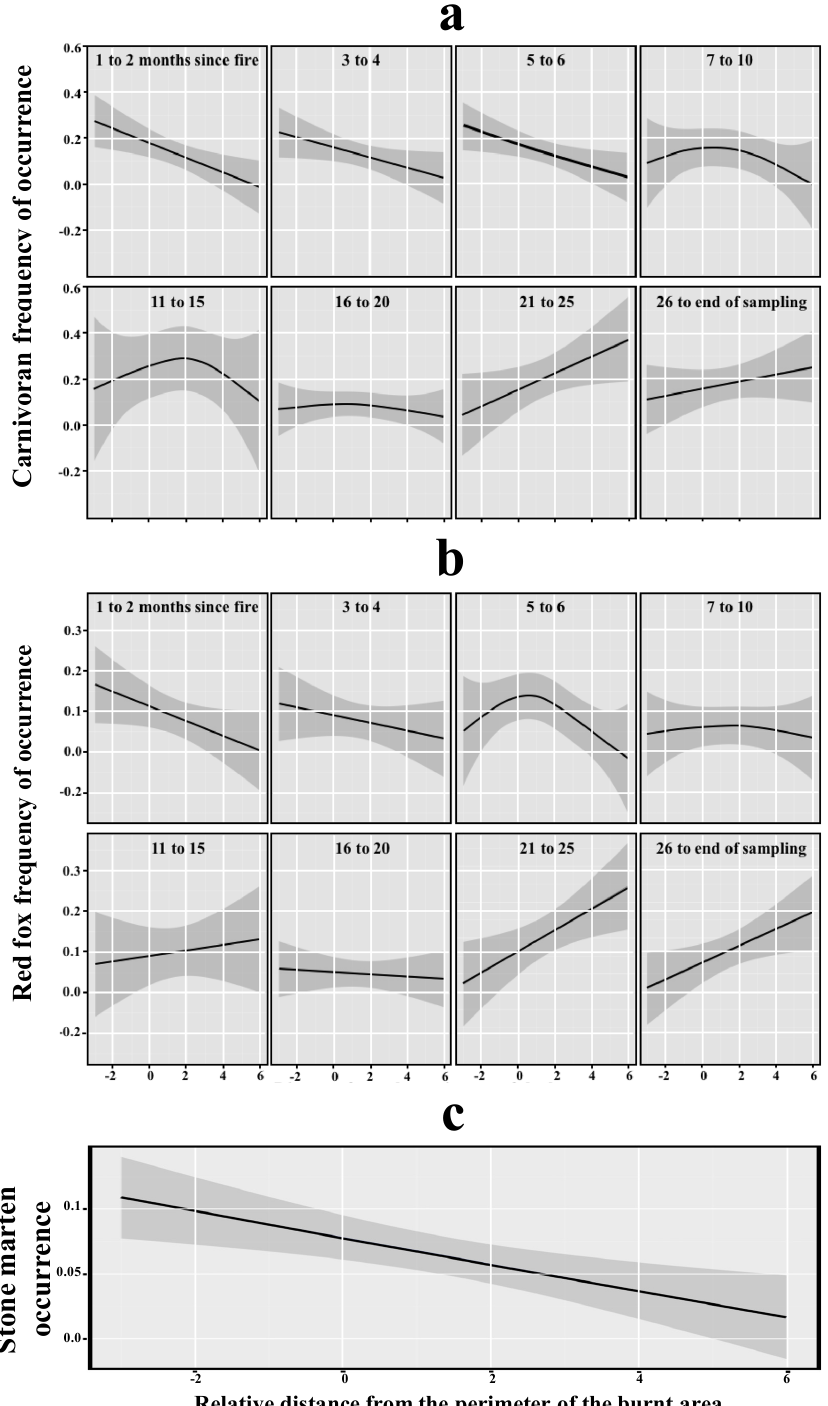
Figure 3. Model predictions of carnivoran frequency of occurrence over time and distance. Marginal e ff ects measure the instantaneous rate of change of the model predictors on ( a ) carnivorans, ( b ) red fox, and ( c ) stone marten frequency of occurrence according to time-since-fire categories and the relative distance from the perimeter of the burnt area. For the distance variable, negative values were assigned to stations in the unburnt area ( − 1 = 1 to 50 m; − 2 = 51 to 100 m; and − 3 = more than − 101 m from the burnt area perimeter), whereas positive values indicate distances within the burnt area (0 = 0 m; 1 = 1 to 50 m; 2 = 51 to 100 m; 3 = 101 to 200 m; 4 = 201 to 400 m; 5 = 401 to 800 m; and 6 = more than 801 m from the burnt area perimeter). Trend line and standard error shown were obtained from GLMM model